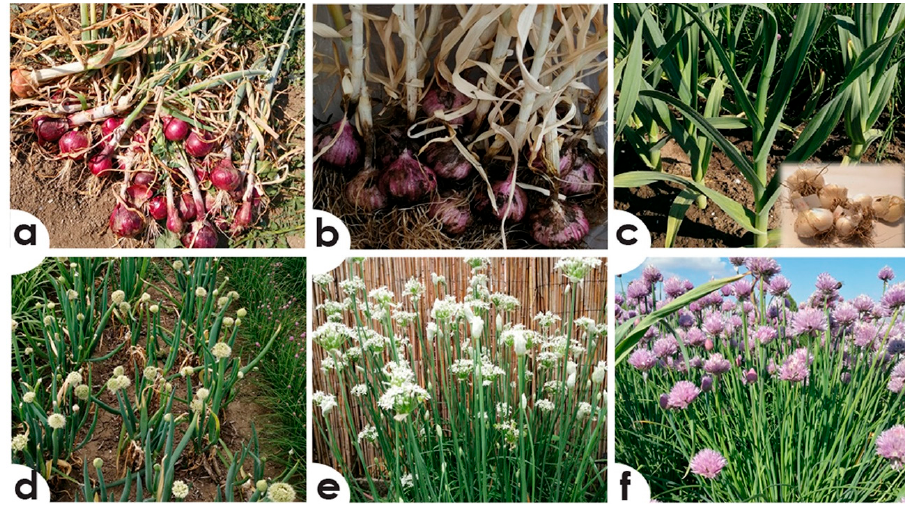
Figure 1. The most important Allium species: ( a ) A. cepa ; ( b ) A. sativum ; ( c ) A. ampeloprasum ; ( d ) A. fi stulosum ; ( e ) A. tuberosum ; and ( f ) A. schoenoprasum (photos by S. Vukovi ć ).